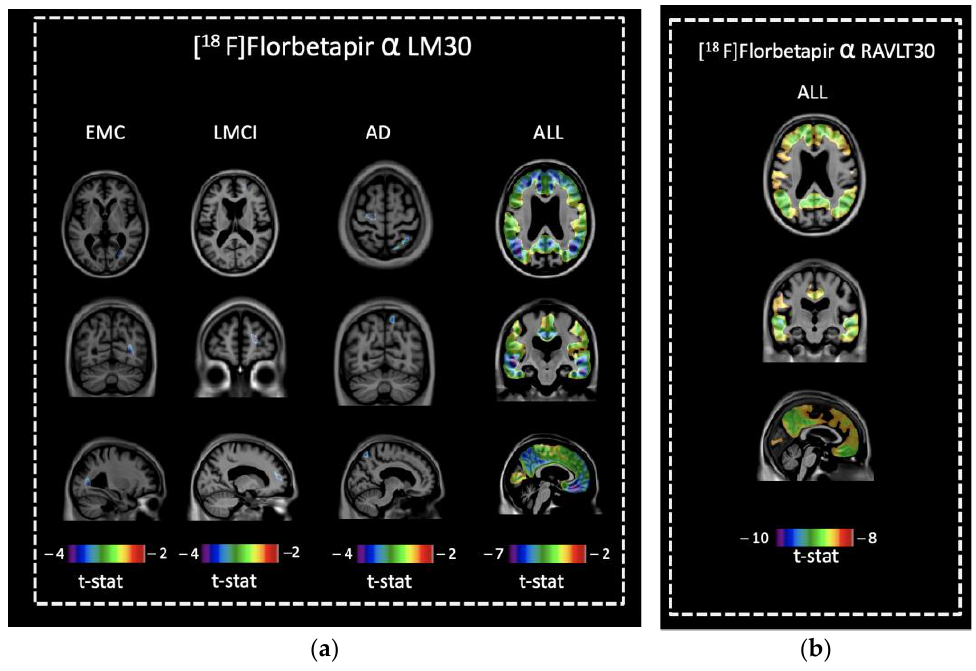
Figure 1. Association between [ 18 F]florbetapir retention and memory scores. ( a ) Negative correlations between [ 18 F]florbetapir retention and LM30 were observed in the right parieto-occipital region for EMCI, in the right frontal lobe of LMCI, and in the right parietal and left frontal lobes of AD. For all groups combined, negative correlation between [ 18 F]florbetapir retention and LM30 was observed in the frontal, parietal, temporal and occipital cortices. ( b ) For all groups combined, negative correlation between [ 18 F]florbetapir retention and RAVLT30 was observed in the frontal, parietal, temporal, and occipital cortices.